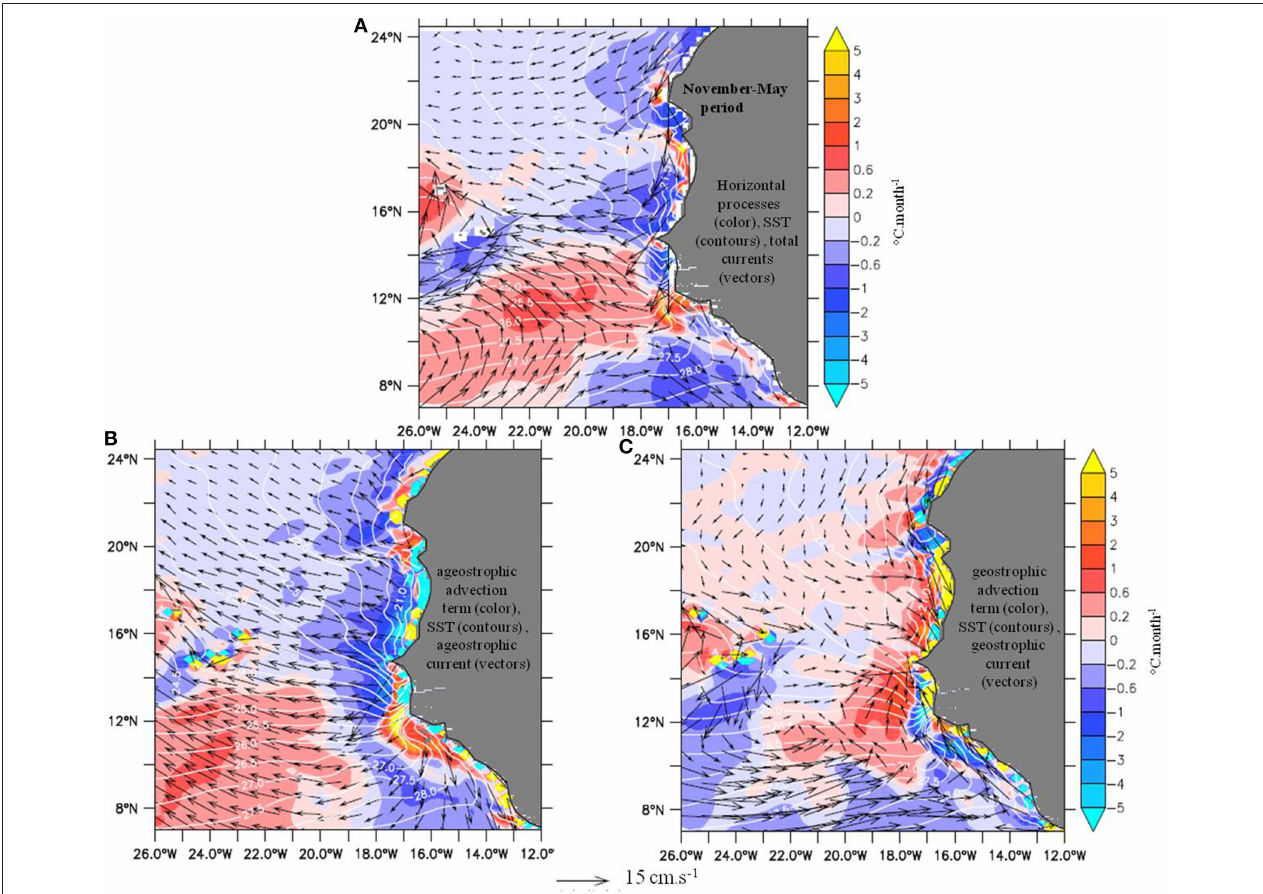
FIGURE 8 | Horizontal processes effect in the model averaged over the CP. (A) Sum of horizontal advection and lateral diffusion (shading, ◦ C.month − 1 ), total currents (black vectors), (B) Ageostrophic advection term (shading, ◦ C.month − 1 ), ageostrophic currents (black vectors), and (C) geostrophic advection term (shading, ◦ C.month − 1 ), geostrophic currents (black vectors), and SST (white contours).